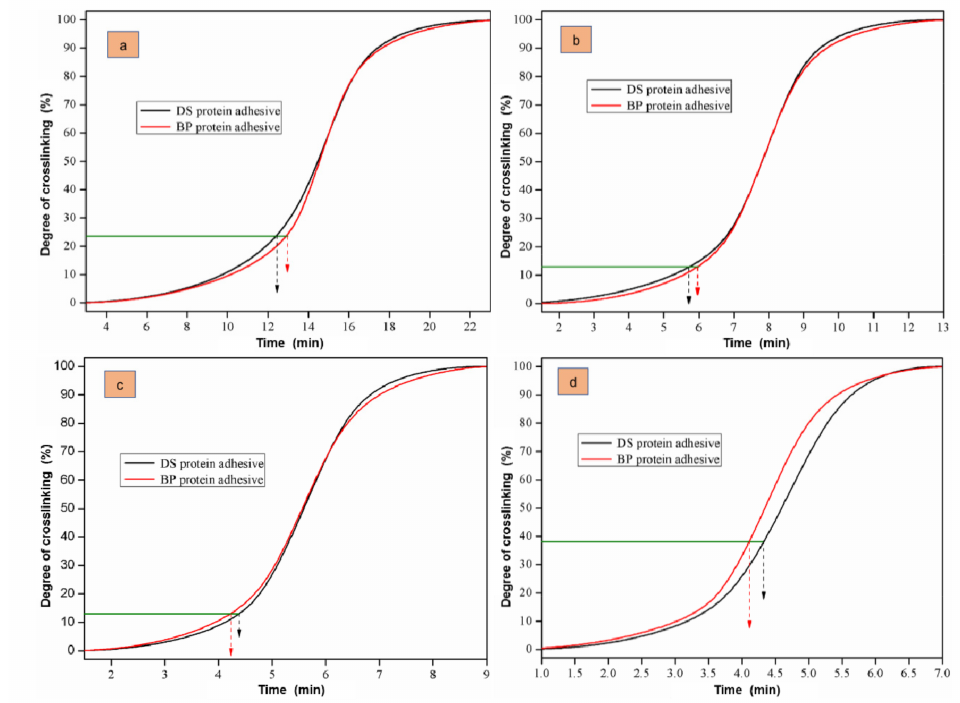
Figure 3. Crosslinking degrees of BP and DS protein adhesives at different heating rates: ( a ) 5 ◦ C/min, ( b ) 10 ◦ C/min, ( c ) 15 ◦ C/min, and ( d ) 20 ◦